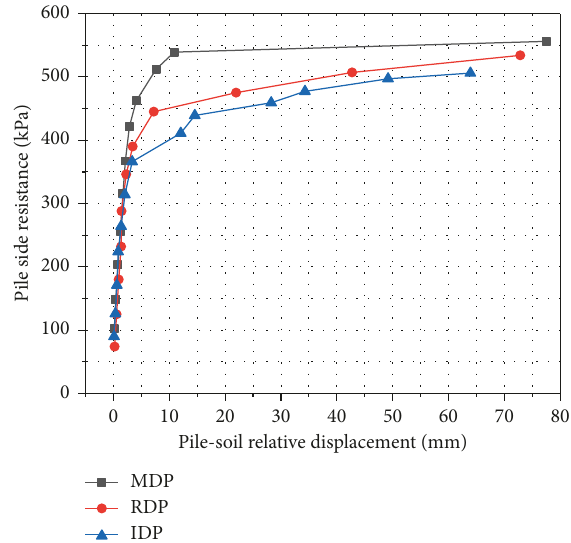
Figure 15: The relationship between pile side resistance and rel- ative displacement of pile-soil.